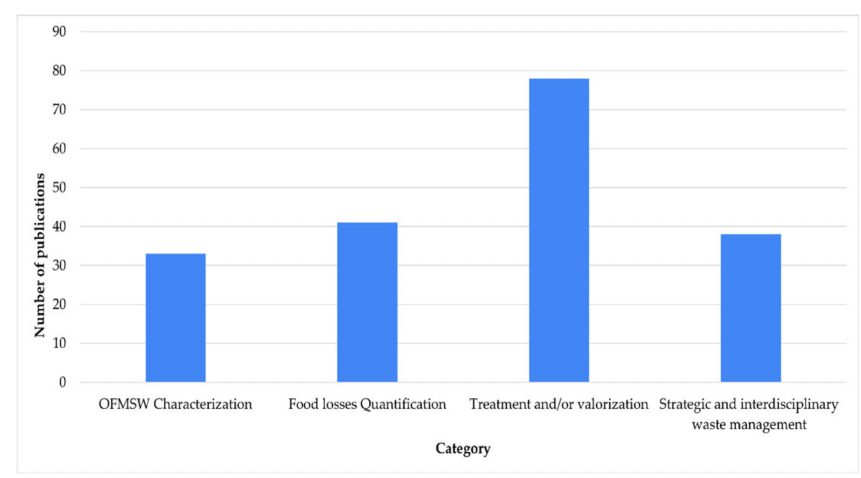
Figure 5. Total of articles published regarding categories of